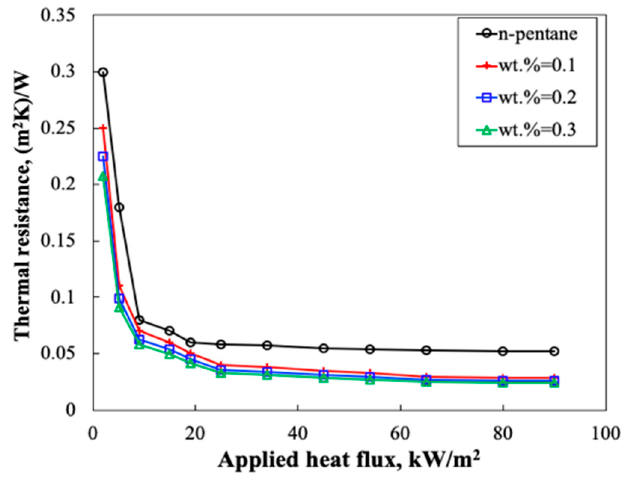
Figure 3. Variation of the thermal resistance with the applied heat flux for n-pentane and nanofluids.